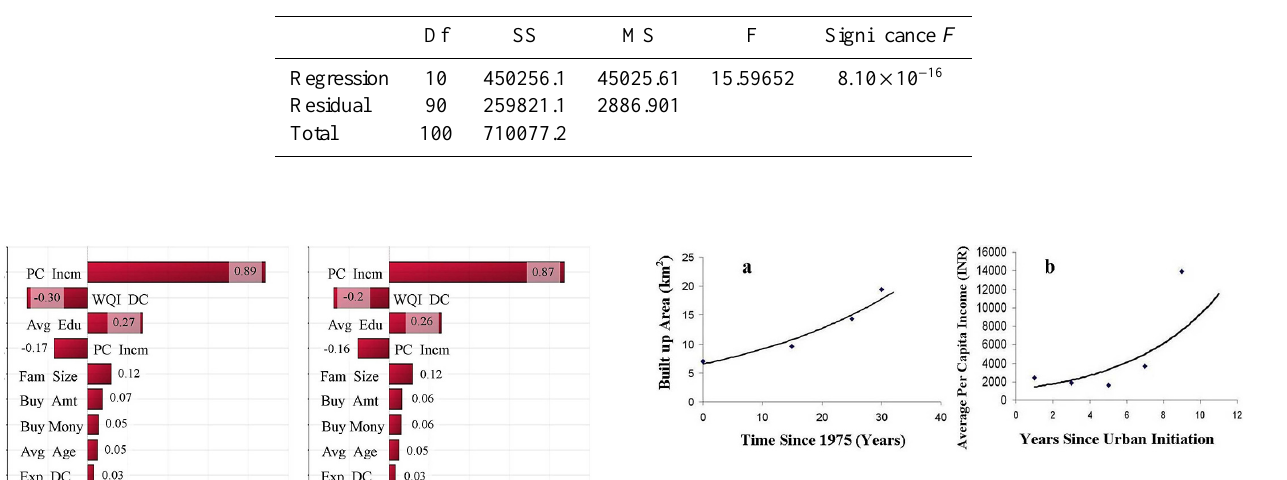
Figure 5. Trends of income and urban